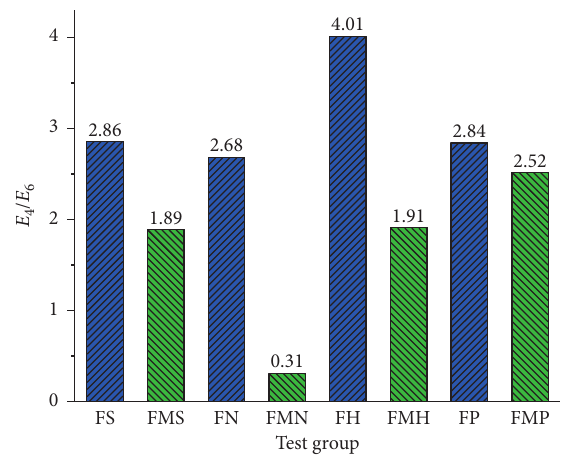
Figure 5: E 4 / E 6 of fulvic